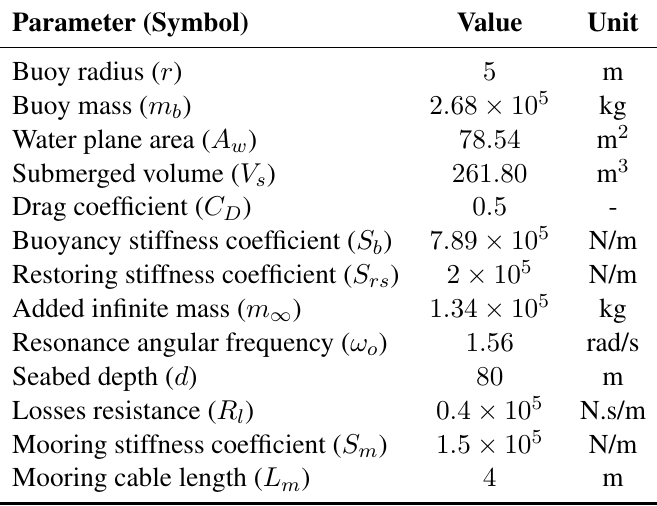
Table 3. WEC design